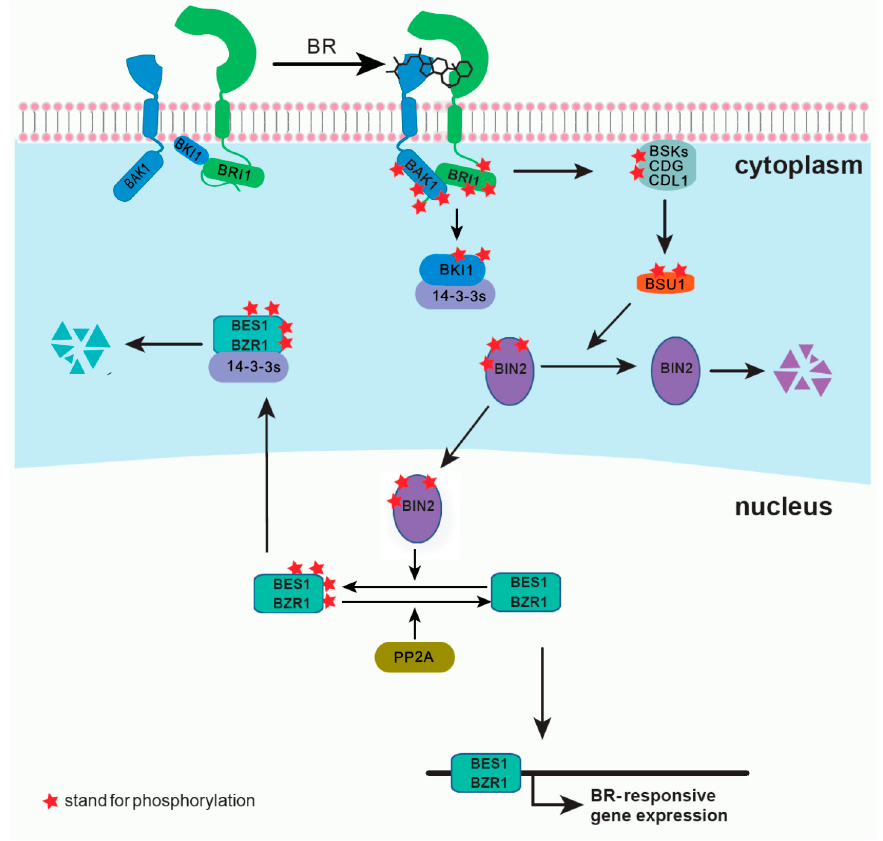
Figure 1. A simplified model for brassinosteroids (BRs) signaling pathway.